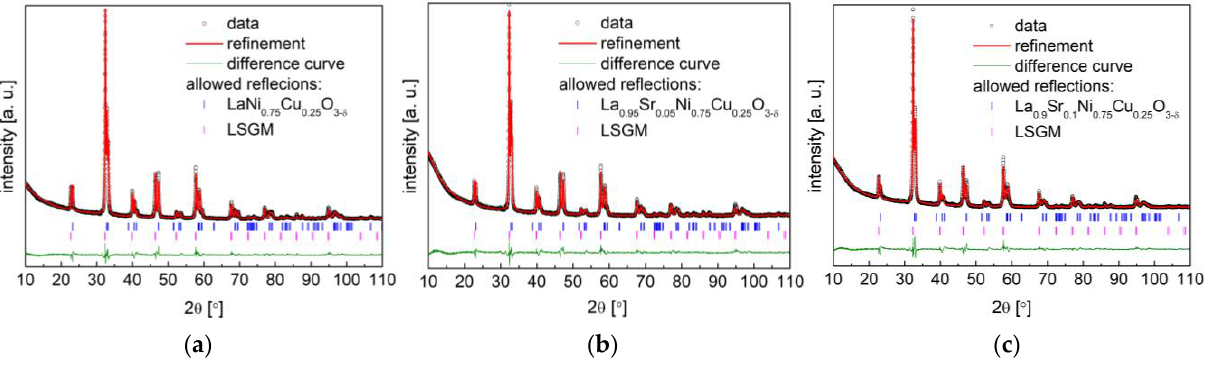
Figure 9. XRD diffractograms with Rietveld refinement of ( a ) LaNi 0.75 Cu 0.25 O 3−δ ; ( b ) La 0.95 Sr 0.05 Ni 0.75 Cu 0.25 O 3−δ ; ( c ) La 0.9 Sr 0.1 Ni 0.75 Cu 0.25 O 3−δ ; ( d ) LaNi 0.5 Cu 0.5 O 3−δ ; ( e ) La 0.95 Sr 0.05 Ni 0.5 Cu 0.5 O 3−δ with Ce 0.9 Gd 0.1 O 1.95 electrolyte after annealing at 800 °C for 100 h.